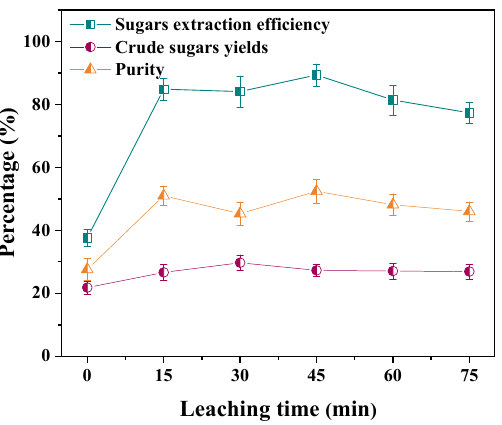
Figure 2. Effects of leaching time on crude sugar yield, purity and sugar extraction efficiency.